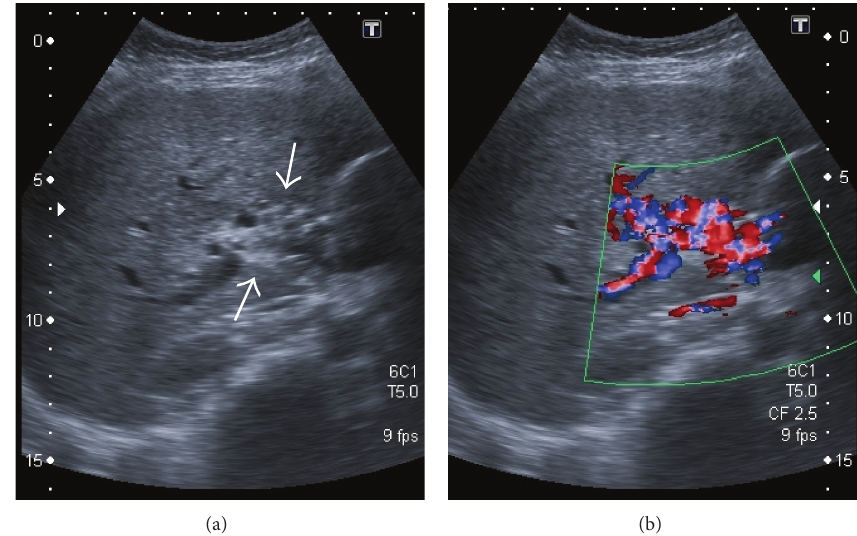
Figure 43: Gray-scale US (a) image showing replacement of the main portal vein by an ill-defined echogenic area containing multiple subtle anechoic tubular structures. On application of colour Doppler (b) turbulent flow can be seen within these anechoic structures consistent with portal